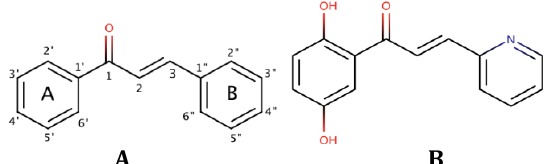
Figure 1. Chemical structure of Chalcone (A) and 1- (2,5-dihydroxyphenyl)-(3-pyridine-2-il)- propenone